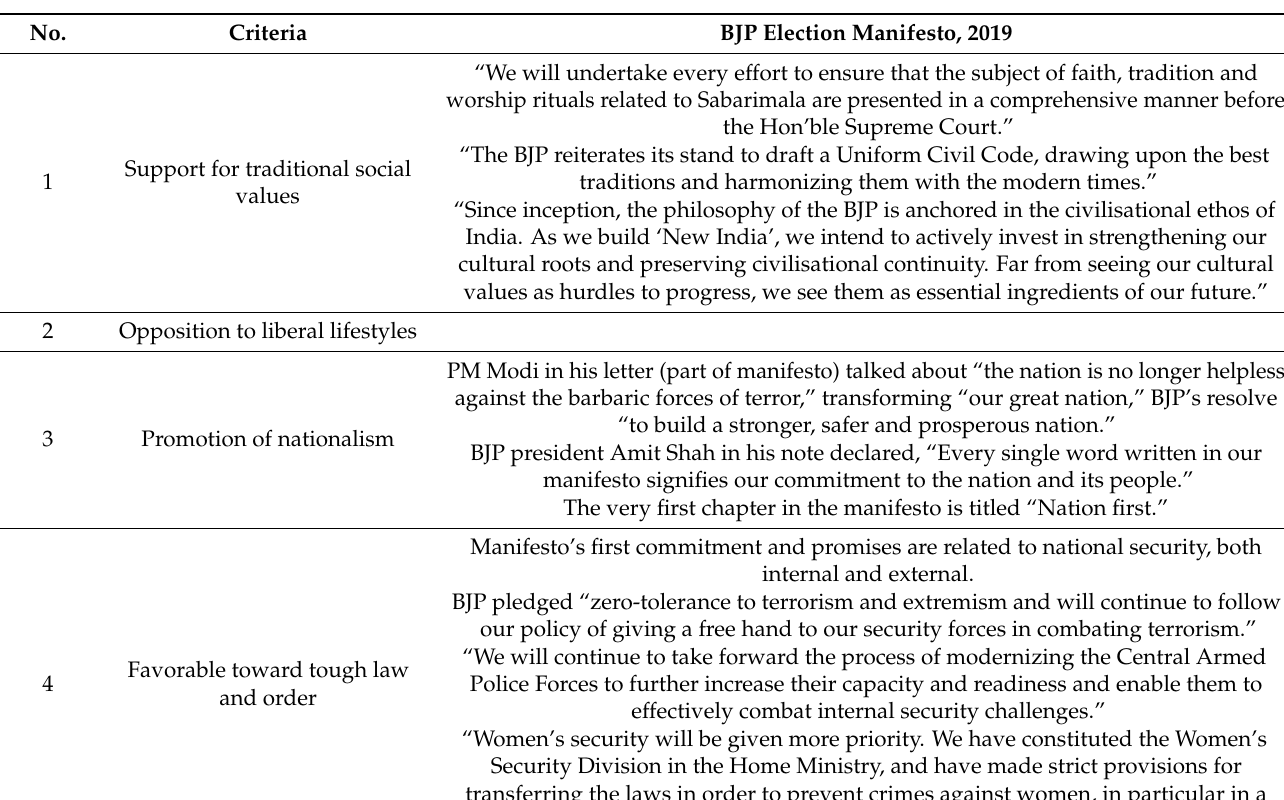
Table 7. Hindu nationalism and populism in Bharatiya Janata Party based on 2019 manifesto (BJP